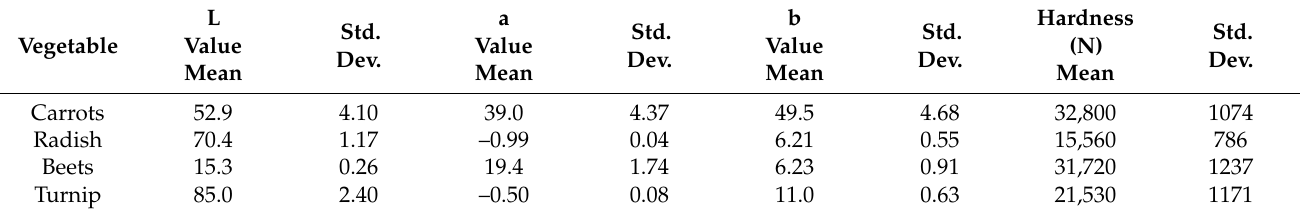
Table 2. Initial quality parameters for fresh